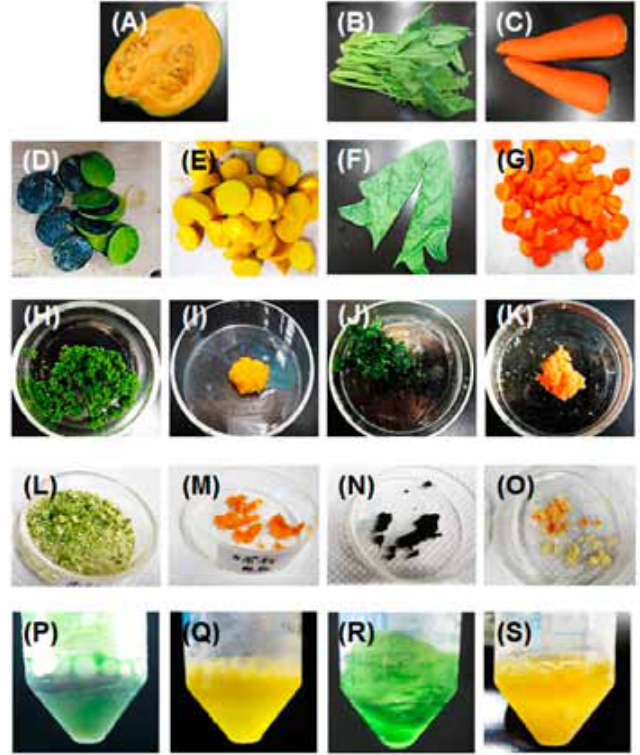
Fig. 2 - Fresh tissues, homogenized paste, dry powder, and pigment mixture of vegetables. Peel and cortex of Japanese squash (A, D, E, H, I, L, M, P, Q), leaves of spinach (B, F, J, N, R) and car- rot roots (C, G, K, O, S) were used for extraction of pigments using DME. Whole vegetables (A-C), fresh tissues prior to ho- mogenization (D-E), paste of homogenates (H-K), dry powder remaining after extraction with DME (L-O), and pigment mix- tures obtained after evaporation of DME (P-S) are shown.